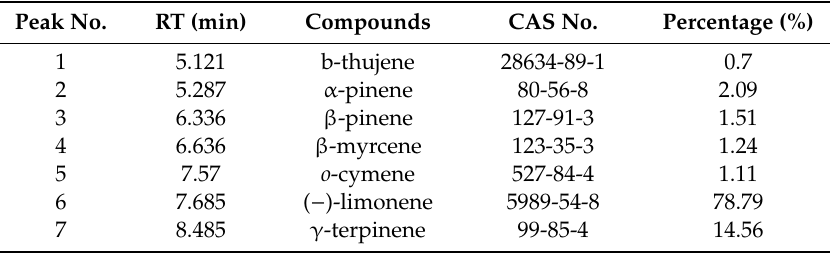
Table 1. Chemical composition (%) of